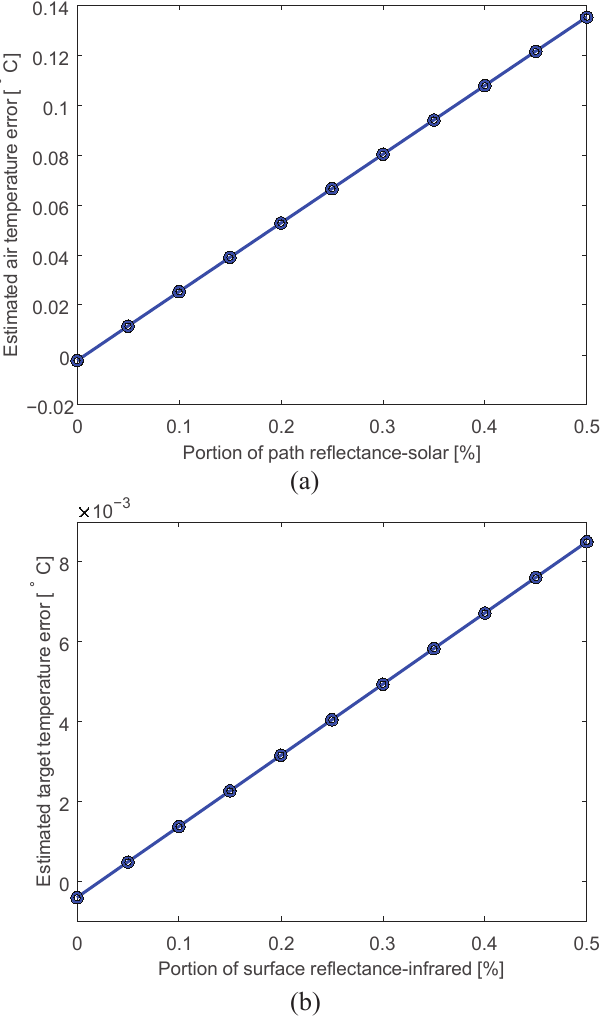
Figure 22. ( a ) Effect of path reflectance-solar in air temperature estimation, ( b ) effect of surface reflectance-infrared in target temperature